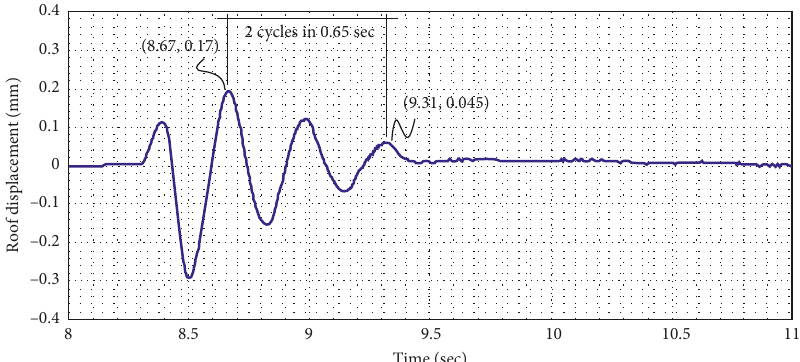
Figure 8: Top-floor displacement response of undamaged bare frame structure for the free vibration test. The values are those for the reduced scale test model.